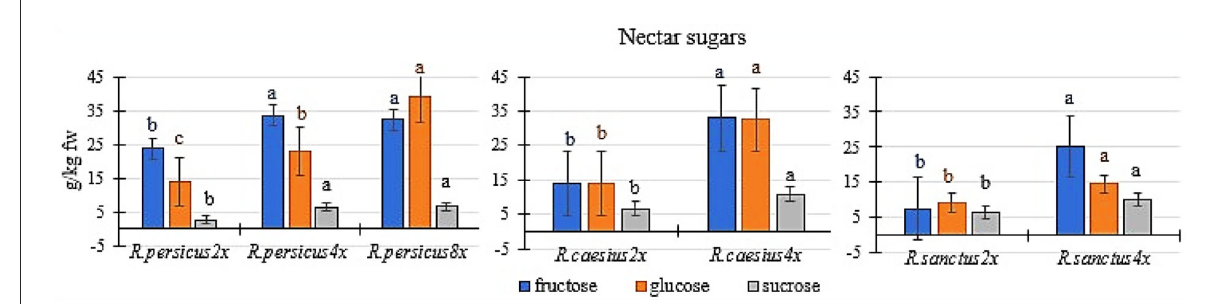
FIGURE4 The concentration of fructose, glucose, and sucrose in the nectar of di and polyploidy plant of R. persicus , R. caesius, and R. sanctus. In each species, means followed by the same letters are not significantly different according to the LSD test at P ≤ 0.05 and the columns with no letters were not significant.